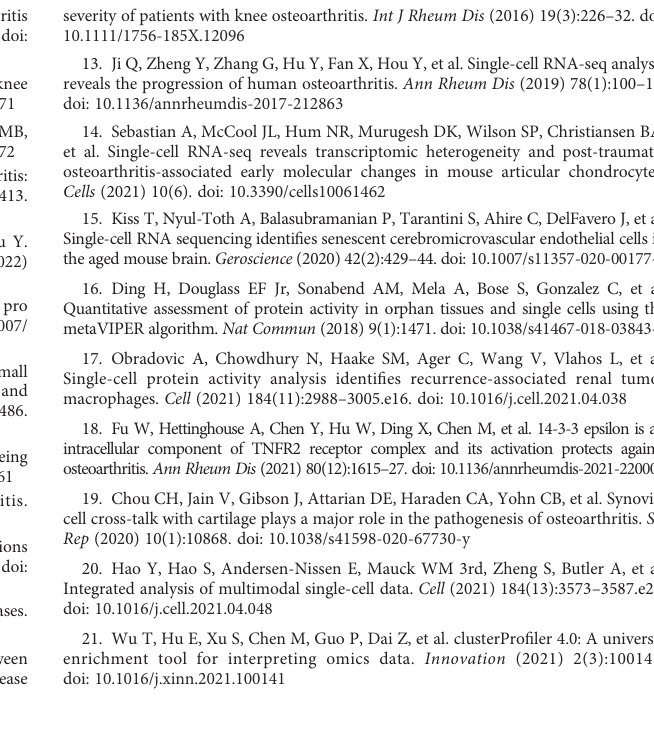
SUPPLEMENTARY FIGURE 4 Single-cell Transcriptome pro fi ling and clustering of human cartilage chondrocytes. (A) Visualization of umap colored according to cell clusters for 24675 chondrocytes from human OA cartilage single-cell transcriptomes. (B) Visualization of umap colored according to cell clusters for 24675 chondrocytes from human OA cartilage split by smooth versus damage label. (C) Visualization of umap colored according to each clinical sample. (D) Visualization of umap colored according to the group of clinical samples. (E) Proportionofdifferentclusterineachclinicalsample. (F) Barplotsshowing the comparison of differentcell clusters between smooth and damage group. (G) Heatmap of the scaled expression of top 5 marker genes for each cluster. All data are expressed as the mean ± SD. Student ’ s t test was used for statistical analysis. p < 0.05 was considered statistically signi fi cant.